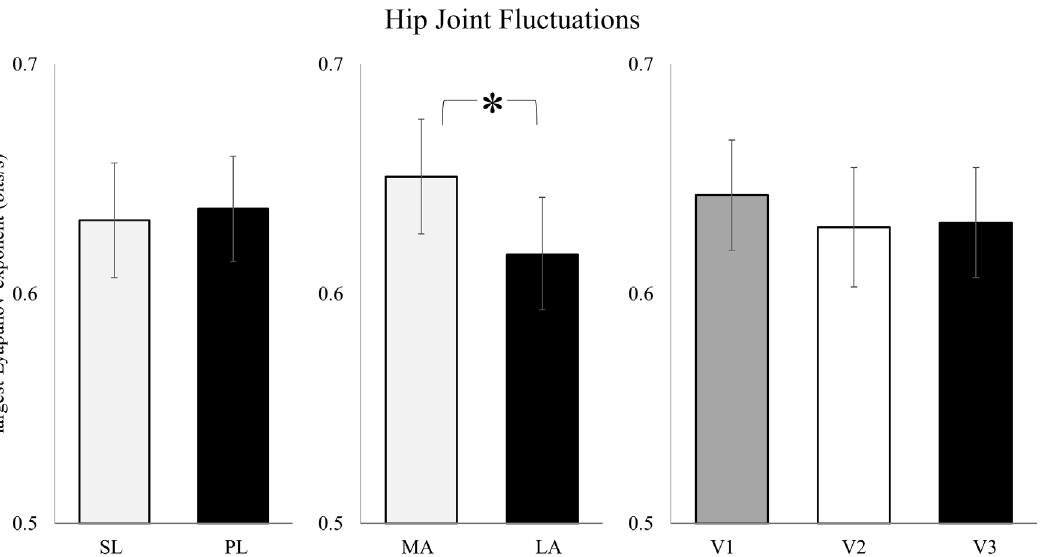
Figure 3. Stride-to-stride fluctuations for the hip were not significantly different for the effect of leg or for changes across the adaptation period. The ‘‘more appropriate’’ prosthesis design did however result in increased fluctuations at the knee compared to the ‘‘less appropriate’’ design. (mean 6 SEM) SL: sound leg; PL: prosthetic leg; MA: ‘‘more appropriate’’ prosthesis; LA: ‘‘less appropriate’’ prosthesis; V1: initial visit; V2: second visit; V3: final visit. *Sig. at p , 0.05.